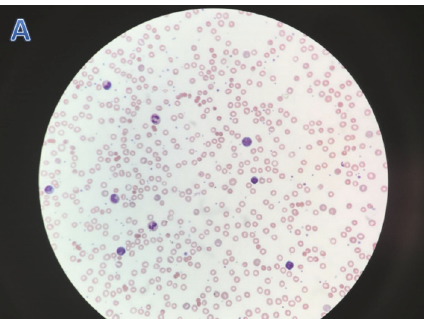
Figure 2: Peripheral blood smears in patients with hemolytic anemia: peripheral smear showed microspherocytes and some increased bands.